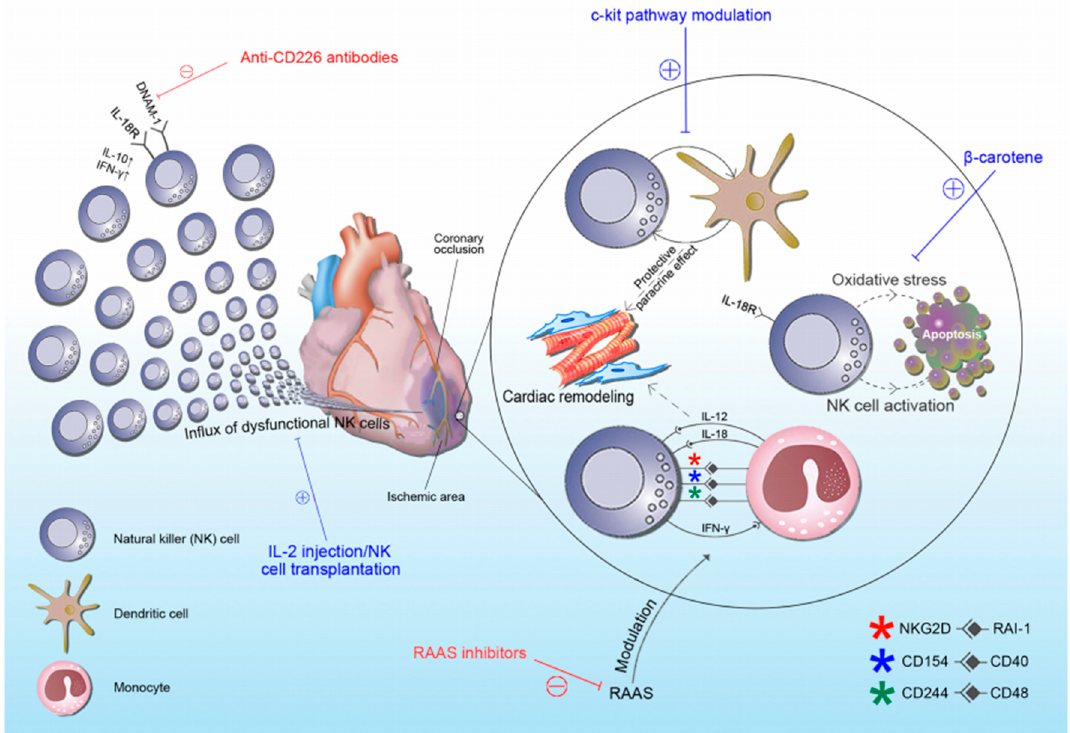
Figure 1. Schematic representation of NK cells’ role in acute coronary syndrome with indicated potential therapeutic targets. Blue lines and “ + ” represent therapeutic options that stimulate NK cell function, whereas red lines and “ − “ represent therapeutic options that inhibit NK cell function.